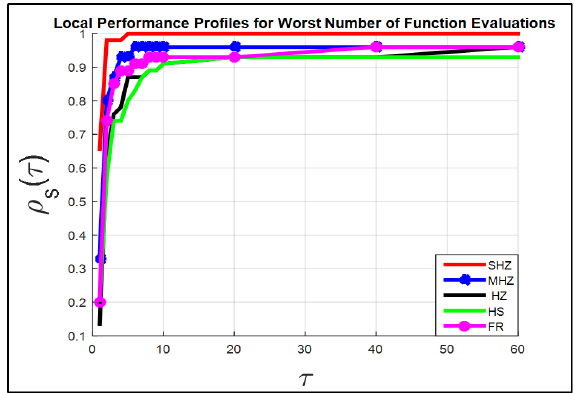
Figure 1. Plotting the results of the terms itr.w and FEs.w for 5 algorithms.